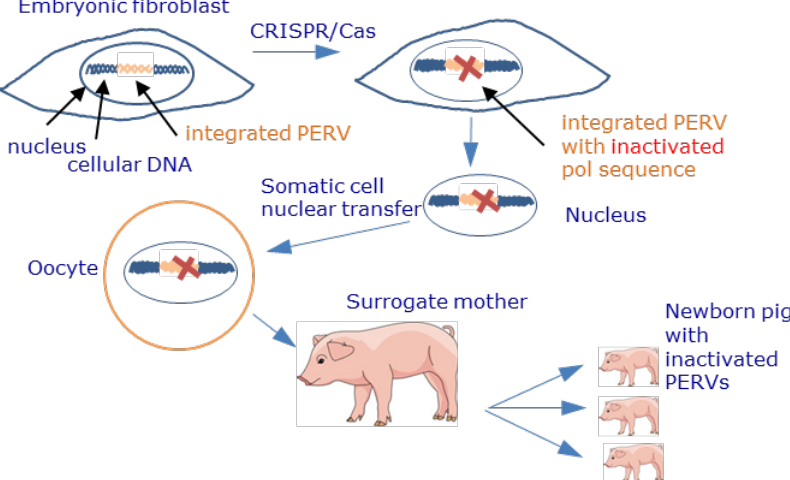
Figure 4. Schematic presentation of the inactivation of PERV proviruses by CRISPR/Cas and generation of piglets with inactivated PERV sequences. Using CRISPR/Cas, the PERV polymerase gene was inactivated, thus preventing the release of infectious viruses. The nuclei of these treated cells were transferred into pig oocytes, giving rise to embryos that were then transferred to surrogate sows. This process resulted in the birth of healthy piglets with inactivated PERVs [126,127].